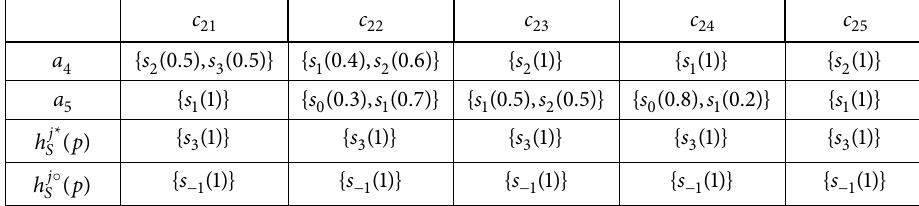
Table 2. The evaluation information of engineering technology talents